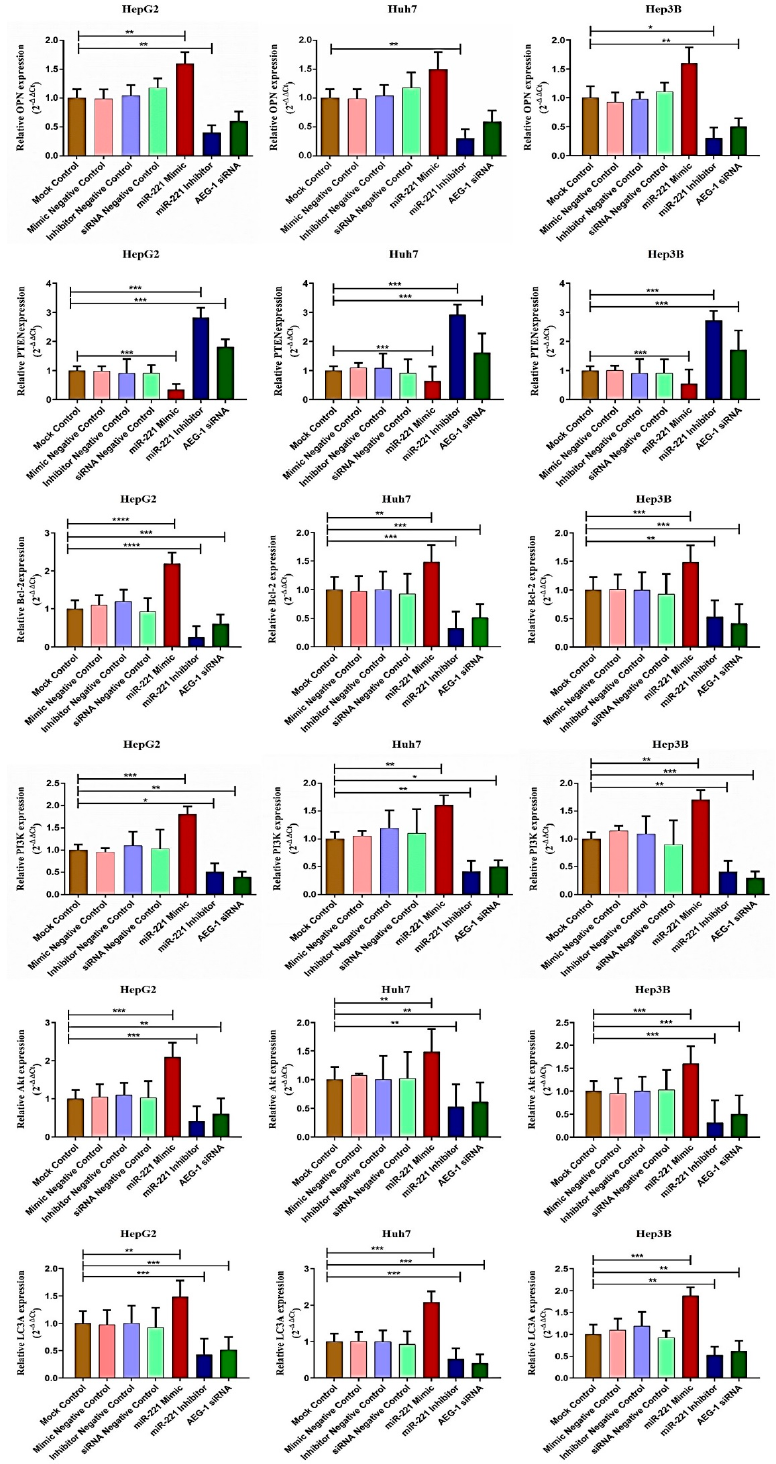
Figure 4. AEG-1/miR-221 regulates the apoptosis and autophagy regulatory mRNAs in the HCC cell lines. The apoptosis and autophagy regulatory mRNAs (OPN, Bcl-2, PTEN, LC3A, PI3K, and Akt) expressions were analyzed in miR-221 mimic-, miR-221 inhibitor, and AEG-1 siRNA-transfected HCC cells by using qRT-PCR, and GAPDH used as an internal control. Error bars presented as mean ± s.d. and p -value represented as * p < 0.05, ** p < 0.01, *** p < 0.001, **** p < 0.0001 compared with corresponding